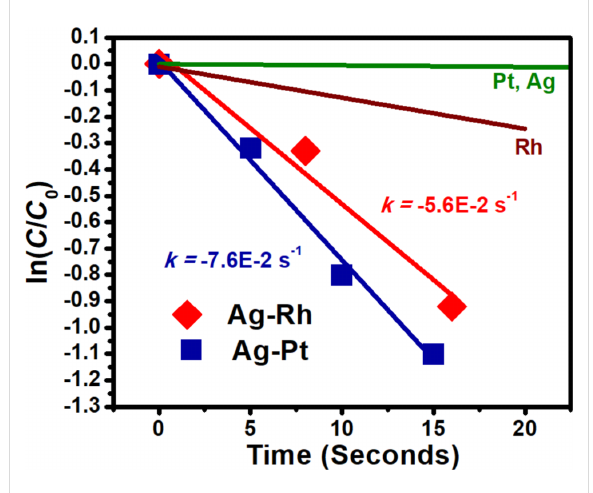
Figure 3: Experimentally observed rate constants in the form of ln( C / C 0 ) = − kt . C 0 is calculated from Abs 400nm prior to the reducing agent spike. t = 0 s is taken as the time the spike occurs. Lines repre- senting the activity of monometallic Rh, Pt, and Ag are included for